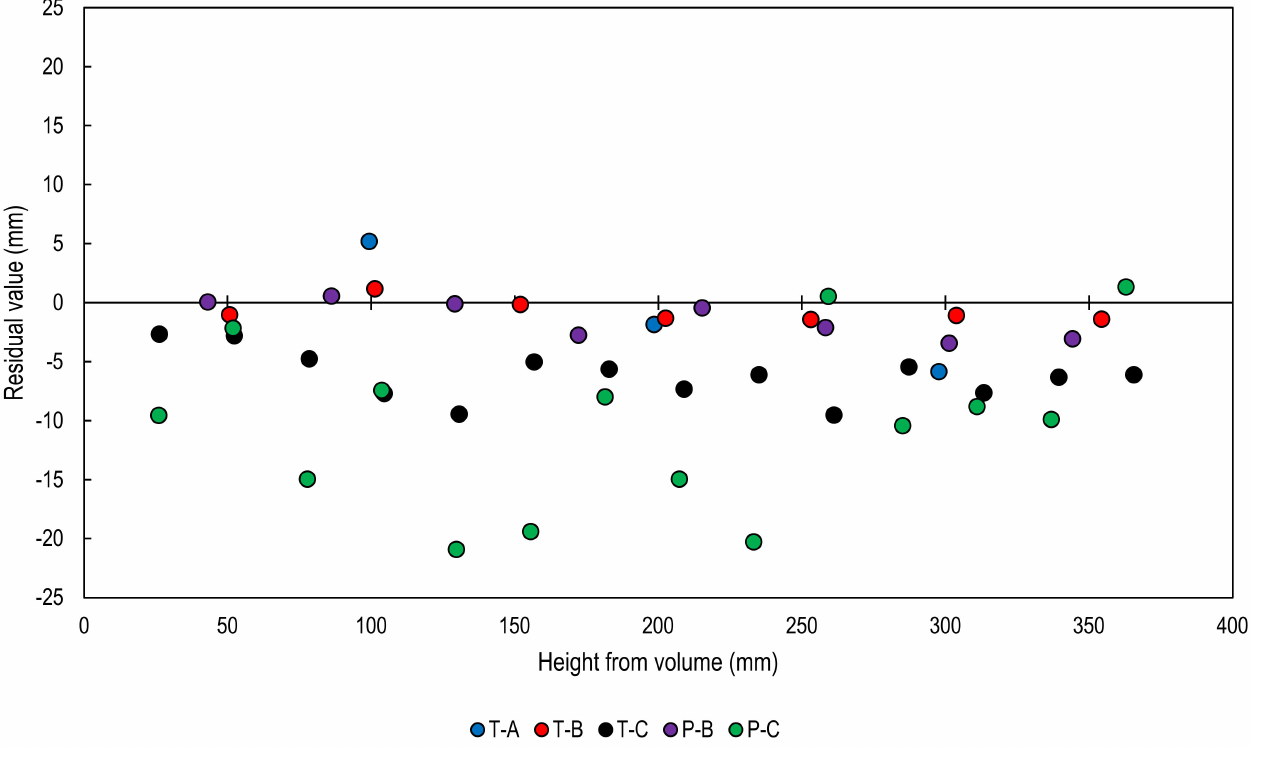
Figure 4. Residual values from the operational performance data